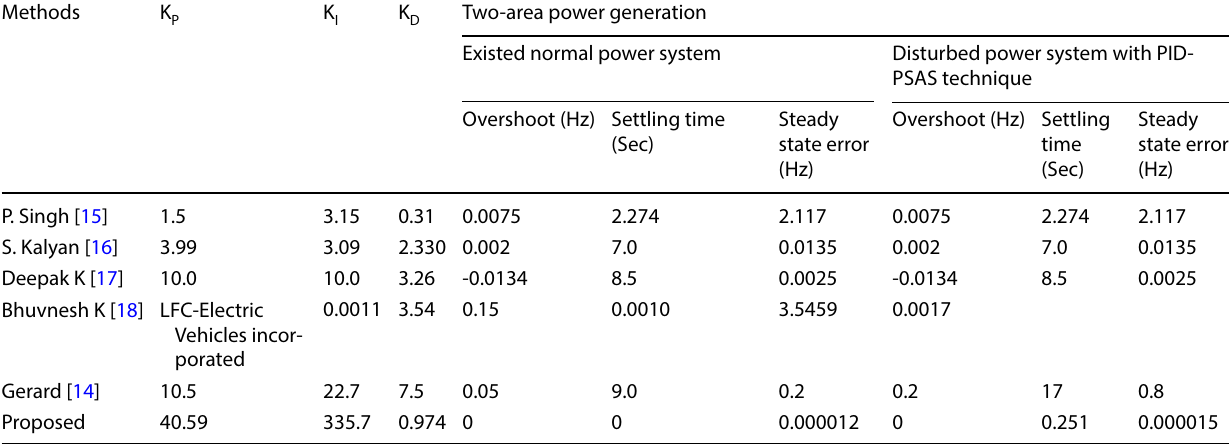
Table 6 Comparison of the research findings of the frequency responses of two controller performances in load increment and decrement condition